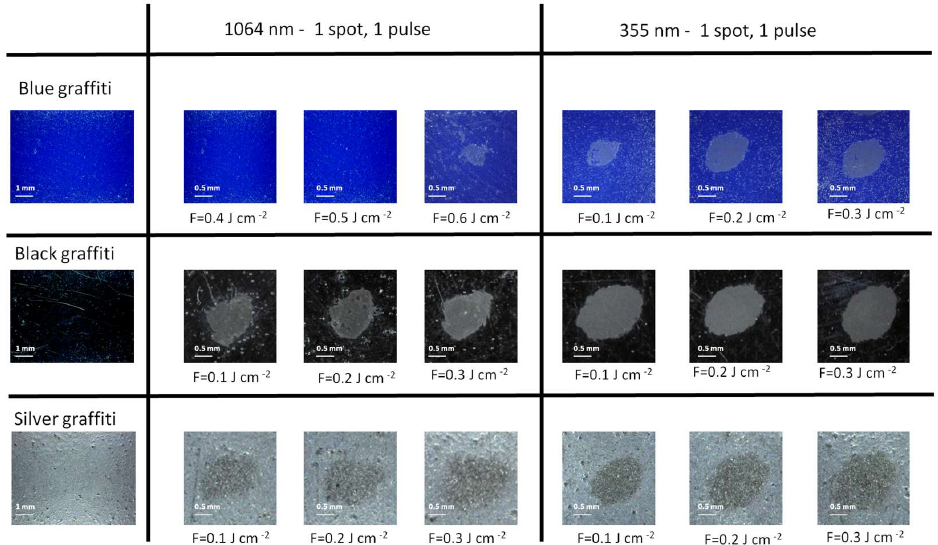
Figure 2. Micrographs taken under stereomicroscopy of the single pulse spots performed at different fluence values ( F ) on the graffiti painted glass slabs. Results for the two wavelengths evaluated (355 nm and 1064 nm) are shown (For interpretation of the references to color, the reader is referred to the web version of this article).